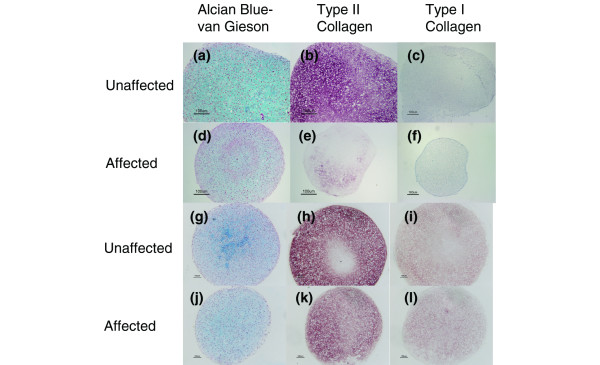
Histology of pellets. The figure shows stained sections of pellets from the unaffected and affected side from same OA donors ((a–f) female, age 81 years and (g–l) male, age 74 years) as shown in Fig. 1. (a, d, g, f) Alcian blue–van Gieson staining indicating the accumulation of proteoglycans. (b, e, h, k) Immunohistochemical staining with anti-type II collagen antibody. (c, f, i, l) Immunohistochemical staining with anti-type I collagen antibody. Positive staining is indicated by a red colour in the extracellular matrix.